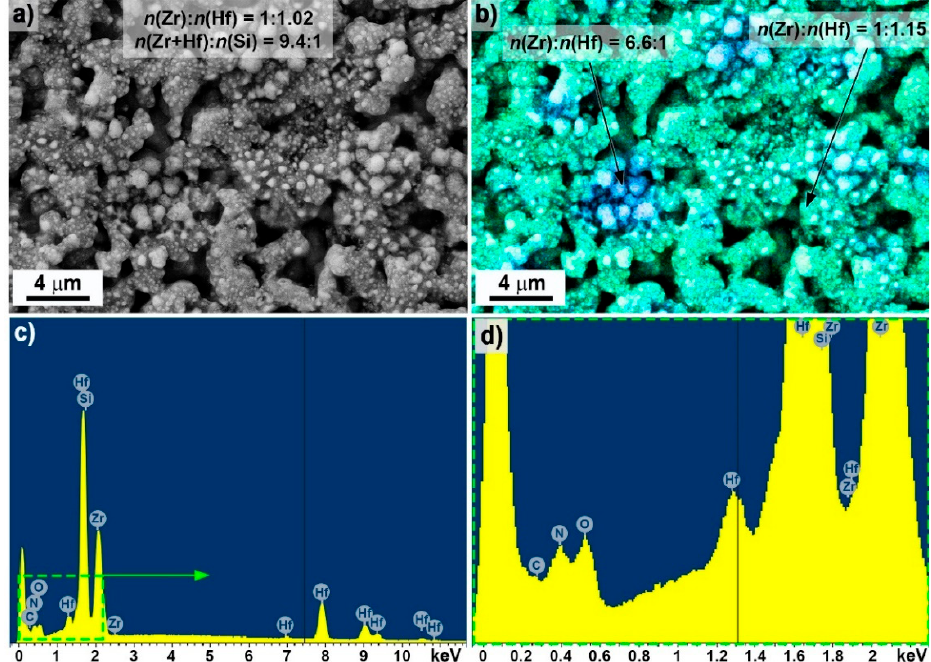
Figure 10. The elemental distribution mapping (( a , b ), zirconium–blue pixels, hafnium–green): X-ray elemental microanalysis data of the entire microphotograph area ( a ) and individual sections ( b ), as well as the corresponding EDX spectrum ( c ), enlarged fragment EDX spectrum ( d ).